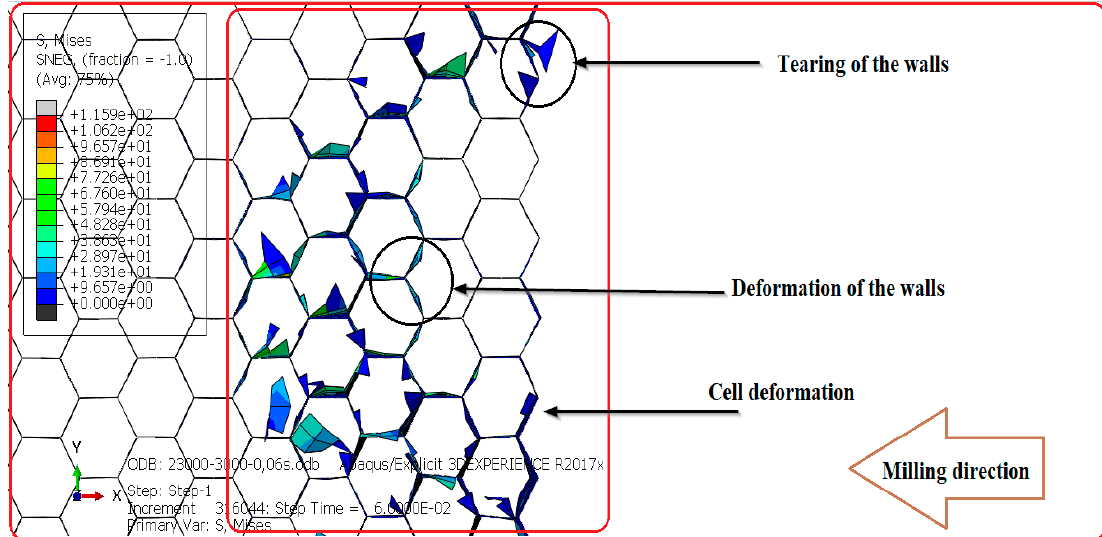
Figure 18. Resulting machined surface quality by the cutting blade of 18.3 mm.